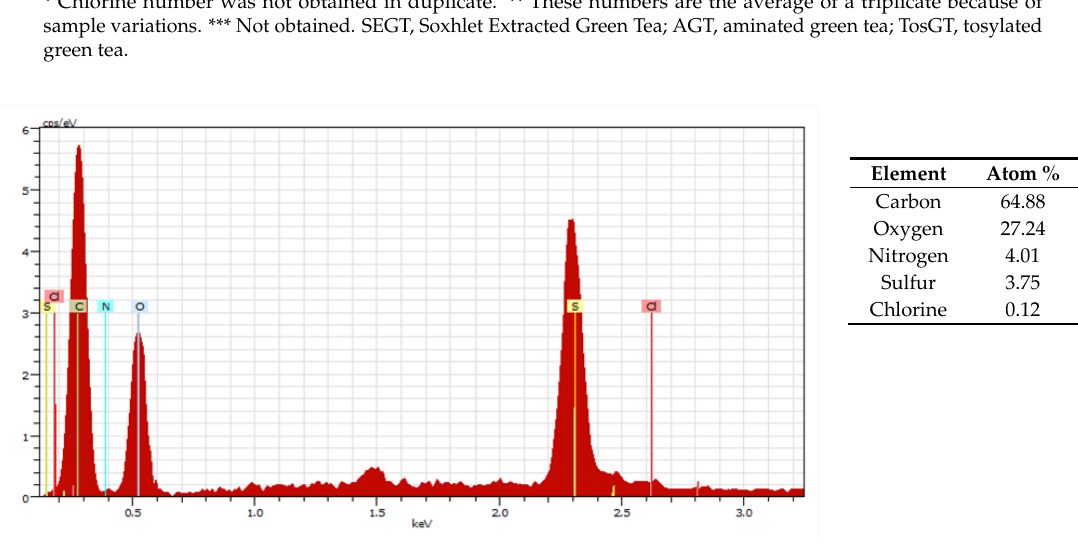
Figure 1. Energy Dispersive X-ray spectra and Atom Percent of the tosylated green tea (TosGT).